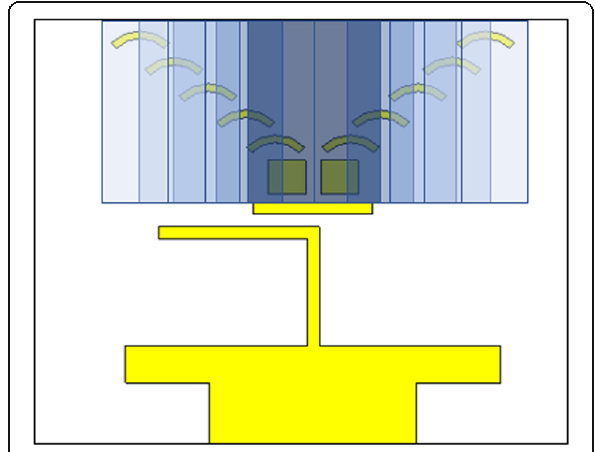
Fig. 14 Gradient depiction of the gradient variation of the refractive index Fig. 15 a Antenna without backplate. b With holed